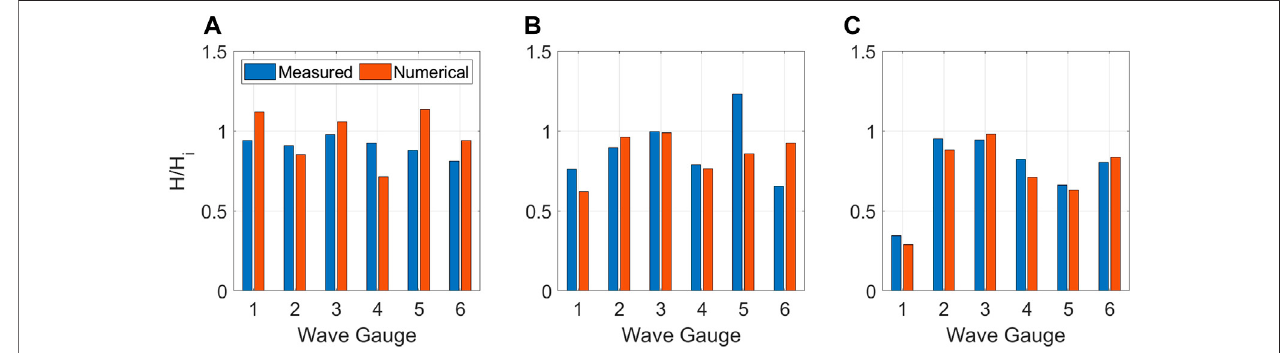
FIGURE 6| Comparison of wave height to offshore wave height ratio at WG1 – 6 between measured and modeled data for (A) Case 1, (B) Case 2, and (C) Case 3.